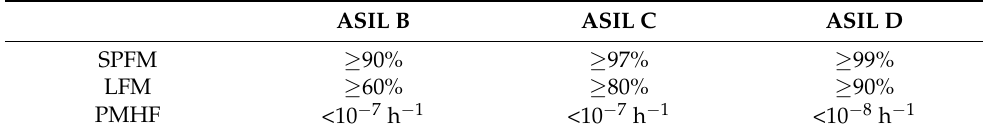
Table 1. Target values of SPFM, LFM, and PMHF for different ASILs.